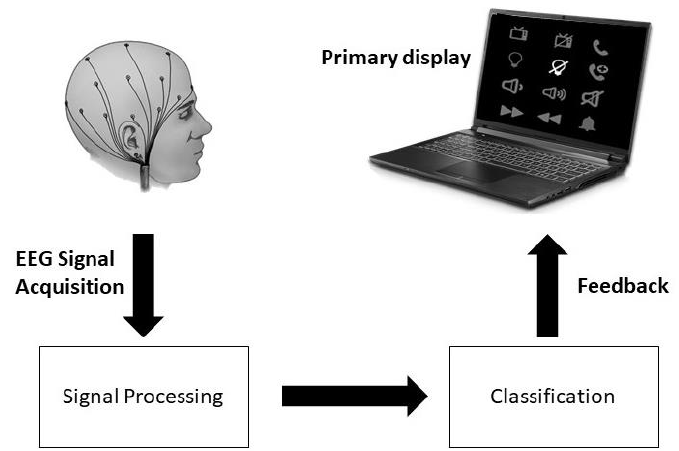
Figure 1. Block diagram of the proposed system.